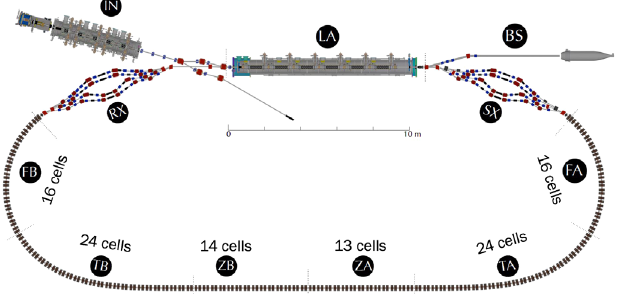
FIG. 2. An example file of 10 dominant horizontal dipole- HOMs assigned to a single CBETA MLC cavity. The HOMs are simulated using CLANS2 program with ϵ ¼ 125 μ m. Note that all the HOM frequencies are above the fundamental frequency 1.3